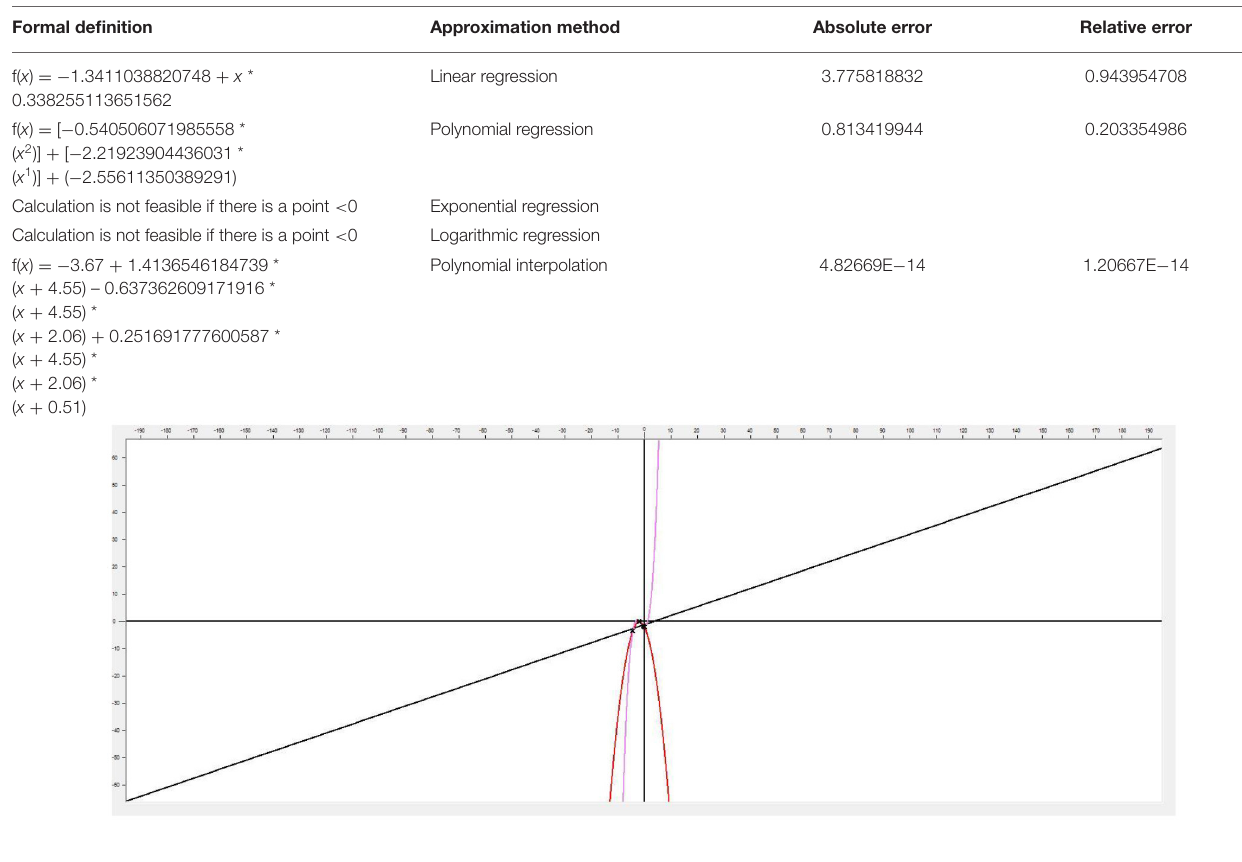
TABLE 8 | Function estimation quadrant III: focus behavior